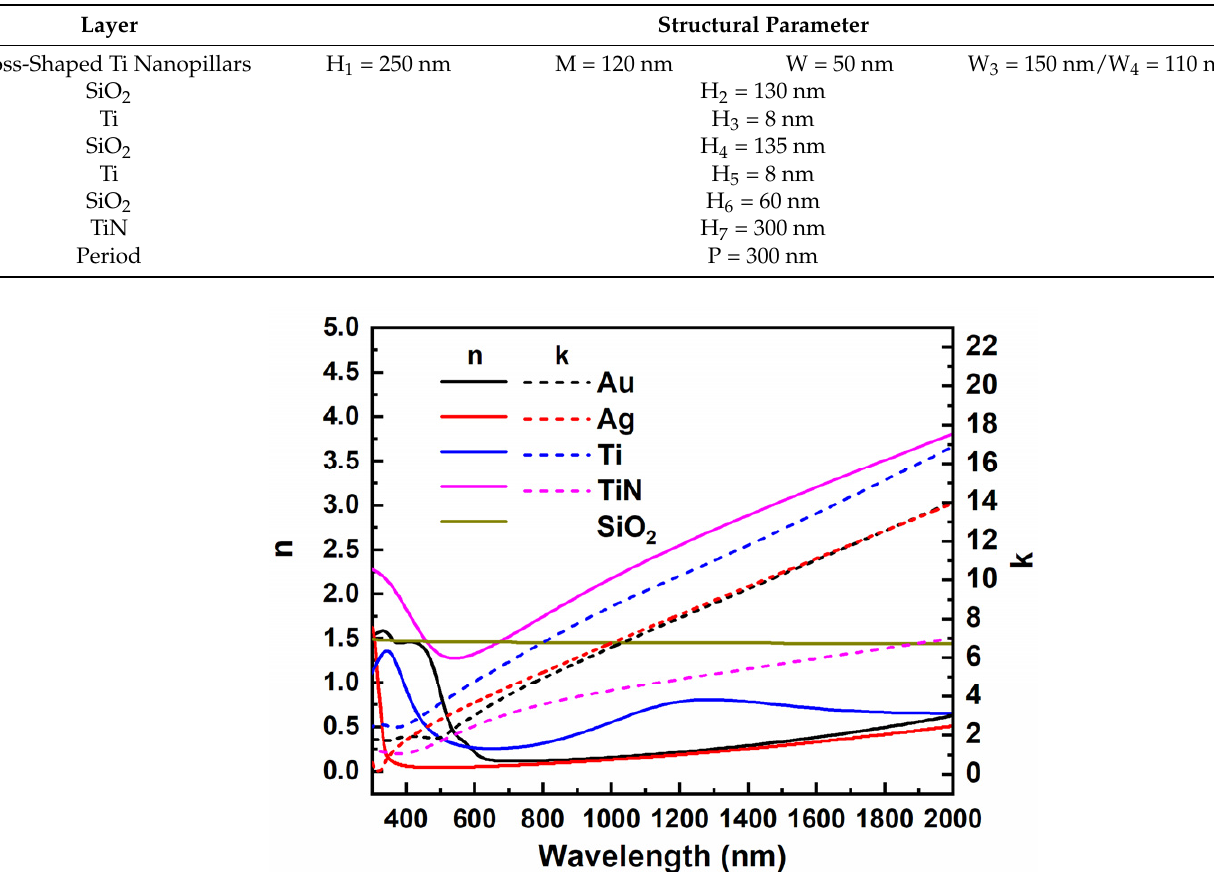
Figure 2. The refractive index and extinction coefficient of materials used in the